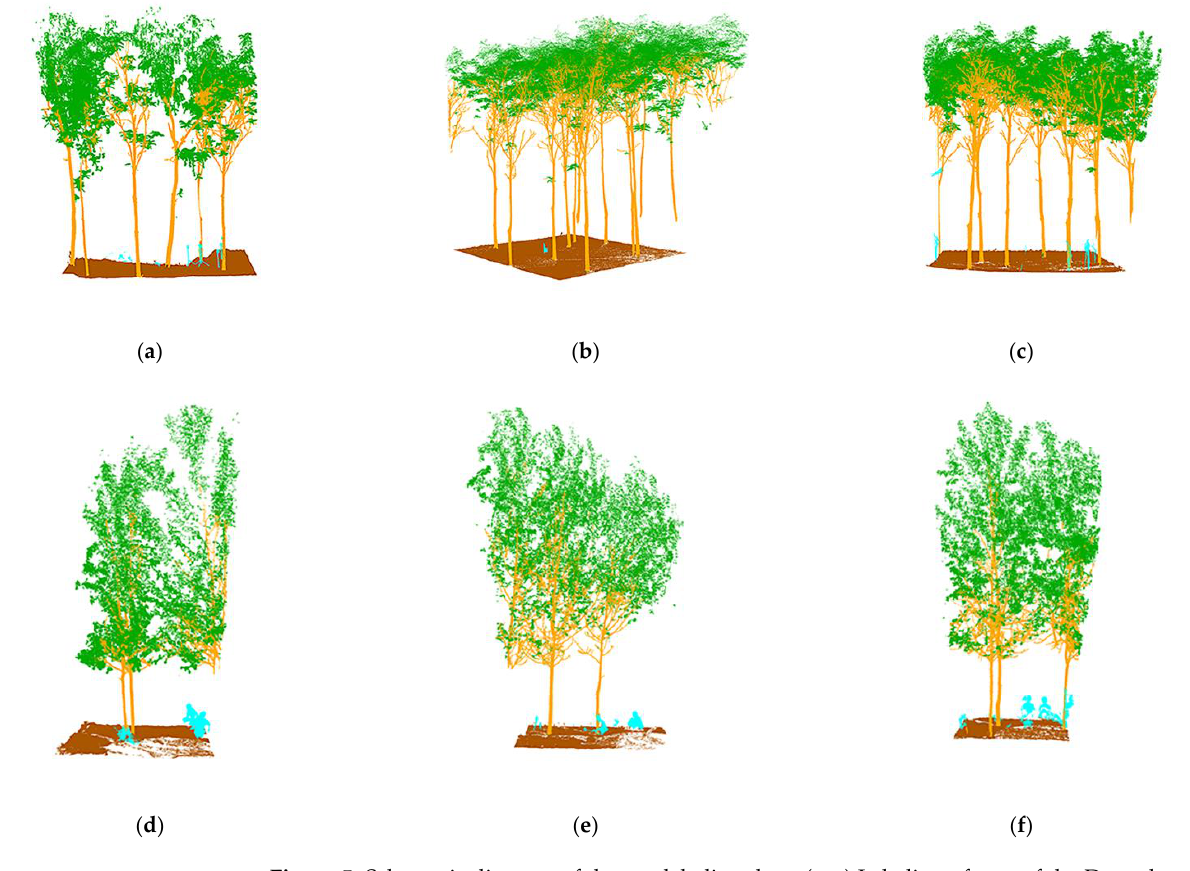
Figure 5. Schematic diagram of dataset labeling data: ( a – c ) Labeling of part of the Dongsheng Bajia dataset; ( d – f ) Labeling of part of the Gaotang triploid Populus tometosa dataset.